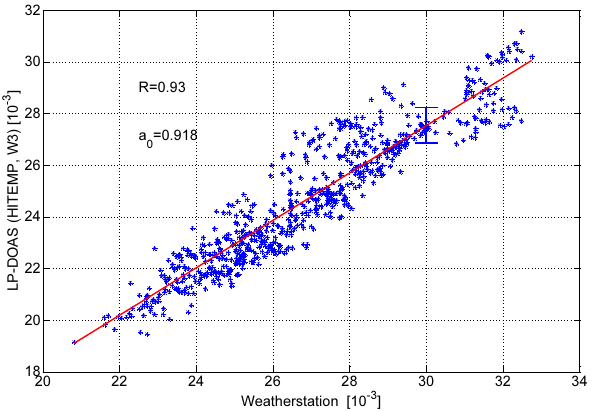
Figure 5. Comparison of LP-DOAS water vapour concentration with data from meteorological station at the CVAO. At 0.03 the error bar shows the mean measurement error of the LP-DOAS mea- surements, estimated by twice the DOAS fit error. The standard de- viation of the residual of the linear fit is 2.5 times as large as the fit